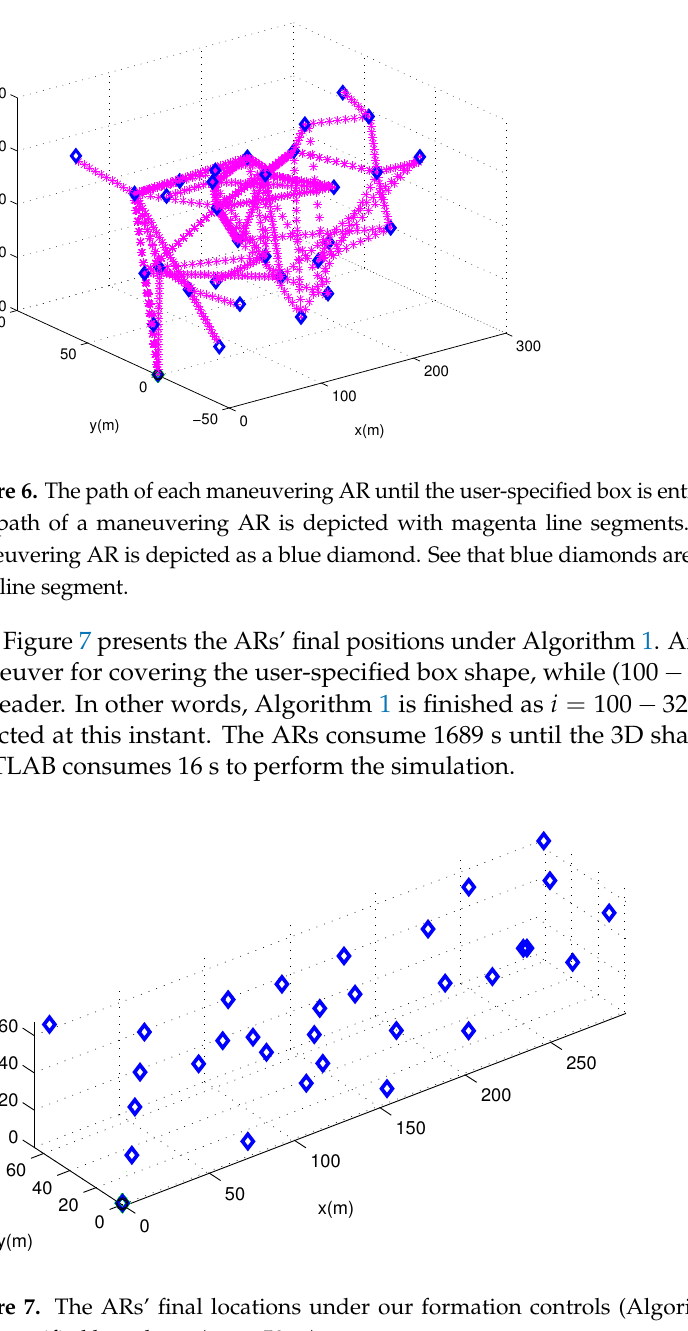
Figure 7. The ARs’ final locations under our formation controls (Algorithm 1) for covering the user-specified box shape ( r sc = 50